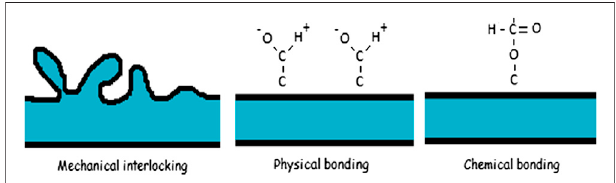
FIGURE 6 | Schematic of three kinds of adhesion